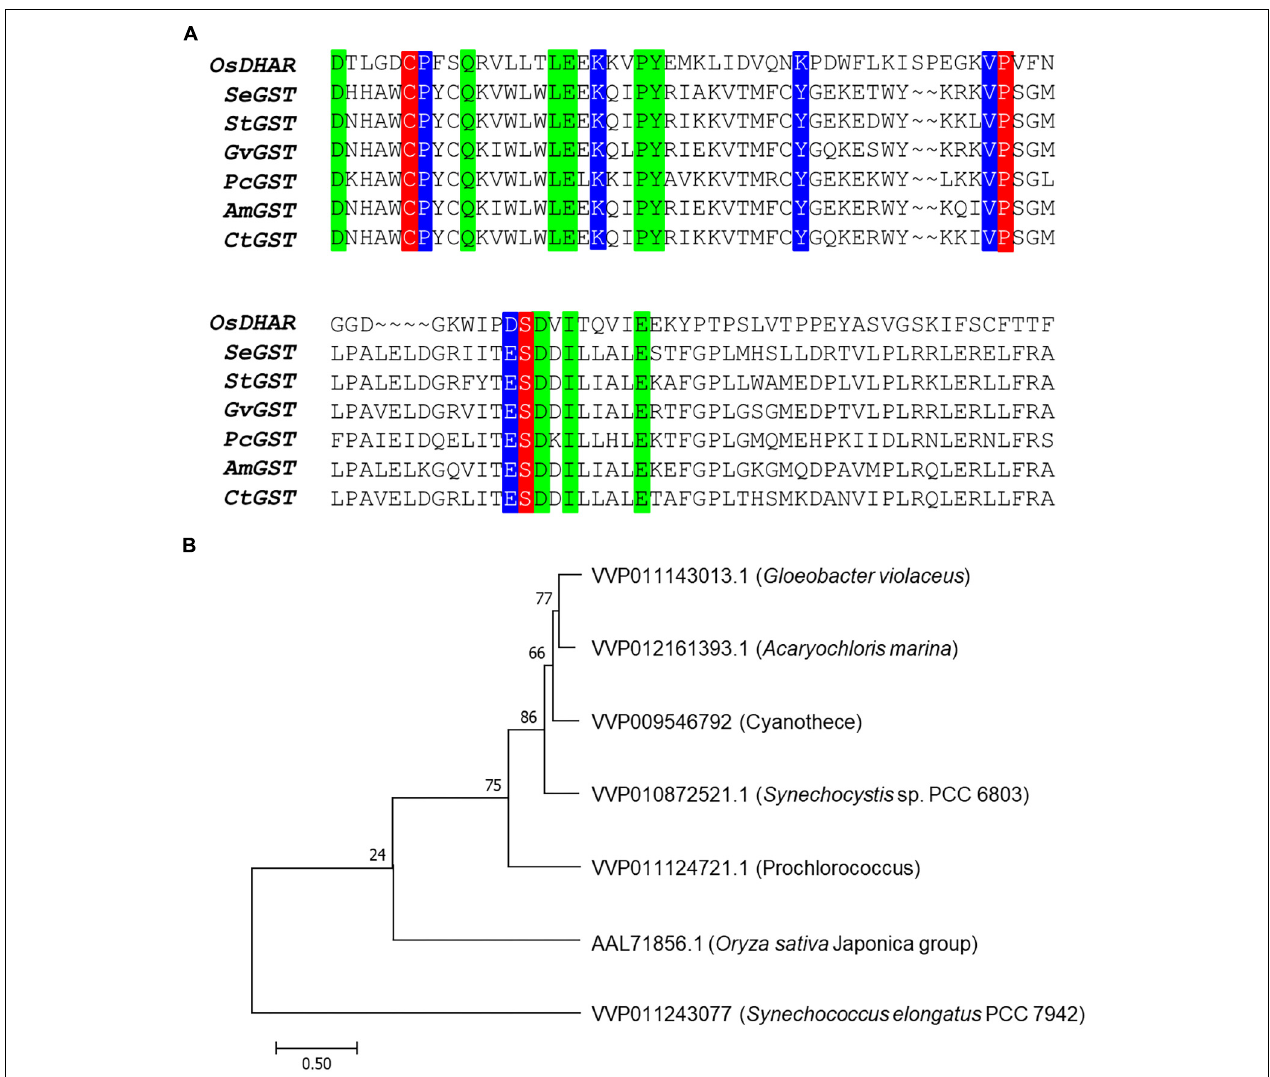
FIGURE 1 | Amino acid alignment of OsDHAR and six glutathione S -transferase (GSTs). (A) Alignment showing GSH binding site and GSTs with similarly functional conserved residues. Colored boxes indicate identical residues across sequences. All contain a conserved site with GSH binding residues (red background), GSTs having similar functional conserved residues (blue background), and strictly conserved residues (green boxes). (B) The phylogenetic trees show the evolutionary relationship between rice DHAR and the amino acids of cyanobacterium GSTs. OsDHAR, Oryza sativa DHAR; SeGST, Synechococcus elongatus PCC 7942 GST; StGST, Synechocystis sp. PCC6803 GST; GvGST, Gloeobacter violaceus PCC 7421 GST; PcGST, Prochlorococcus marinus MIT9313 GST; AmGST, Acaryochloris marina MBIC11017 GST; CtGST, Cyanothece sp. ATCC 51142